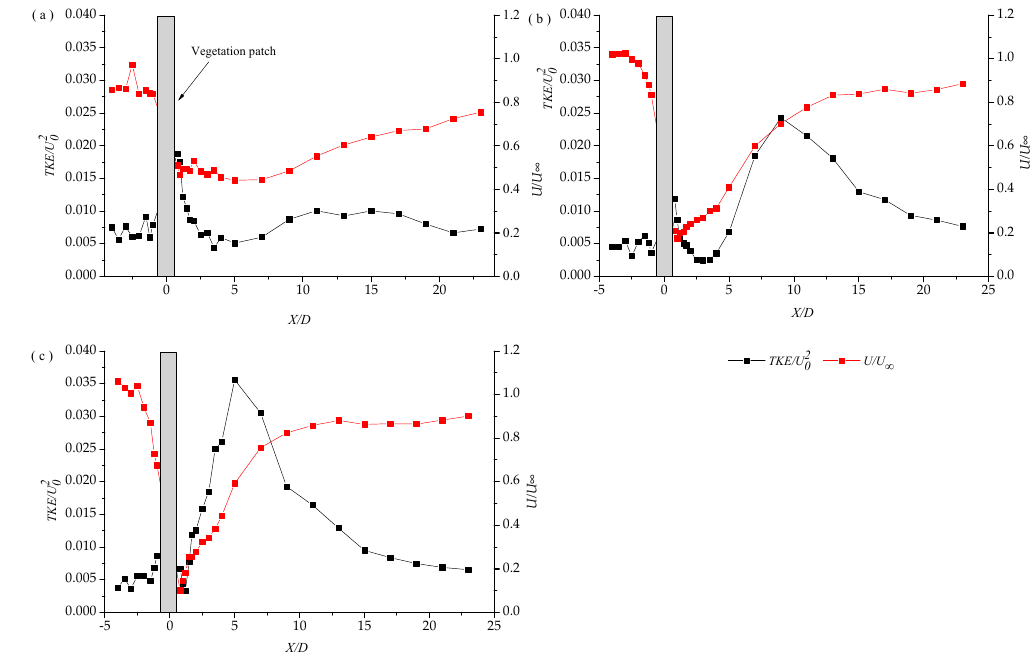
Figure 10. Longitudinal distributions of the main flow velocity and turbulent kinetic energy at the centerline of the vegetation community for different densities: ( a ) a = 0.3 cm − 1 ; ( b ) a = 0.5 cm − 1 ; and ( c ) a = 0.8 cm − 1 .